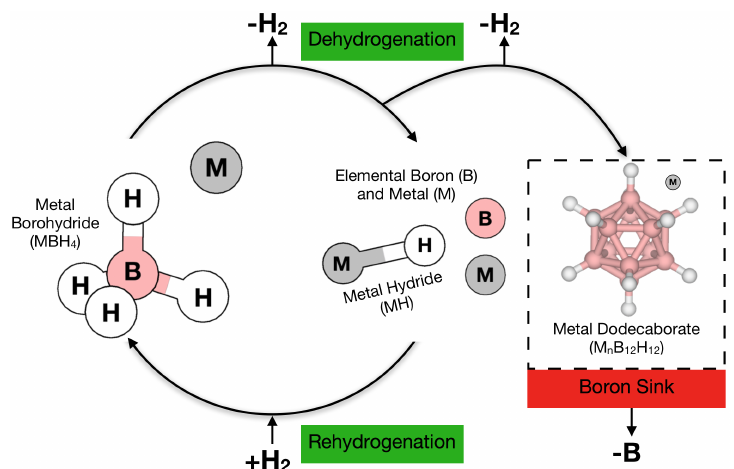
Figure 9. Schematic representation of the role of dodecaborates in the borohydride hydrogenation